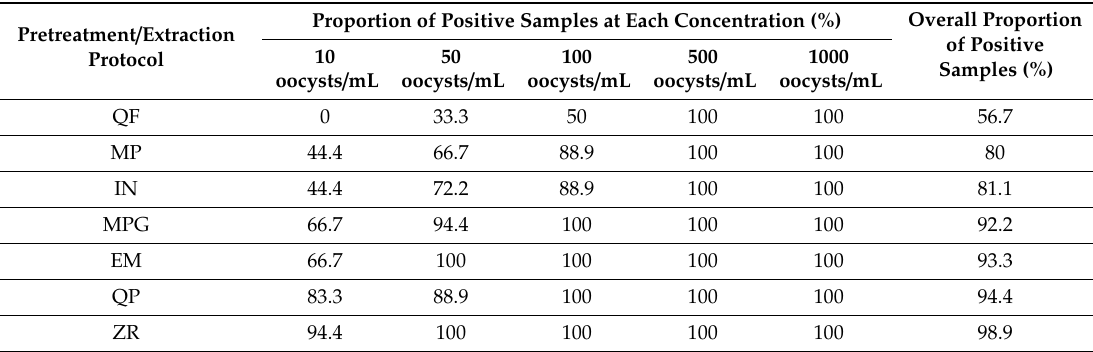
Table 4. Performances of six C. parvum DNA pretreatment / extraction protocols studied. Pretreatment /